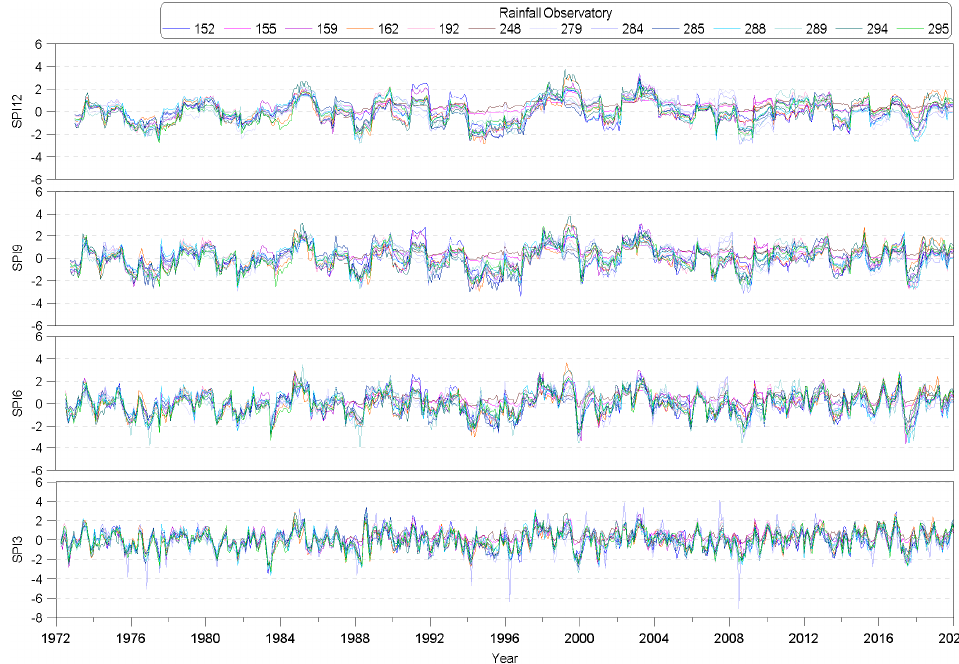
Figure 5. Results of SPI analysis by duration for the rainfall stations affecting Gyeonsangnamdo. SPI3 ranged from − 3.15 to 2.91 on average for each station, and the minimum and maximum SPI ranging from − 7.08 to 4.09 were observed from the Geochang station (no. 284). In addition, SPI6 ranged from − 2.65 to 2.69 on average, and the minimum SPI ranging